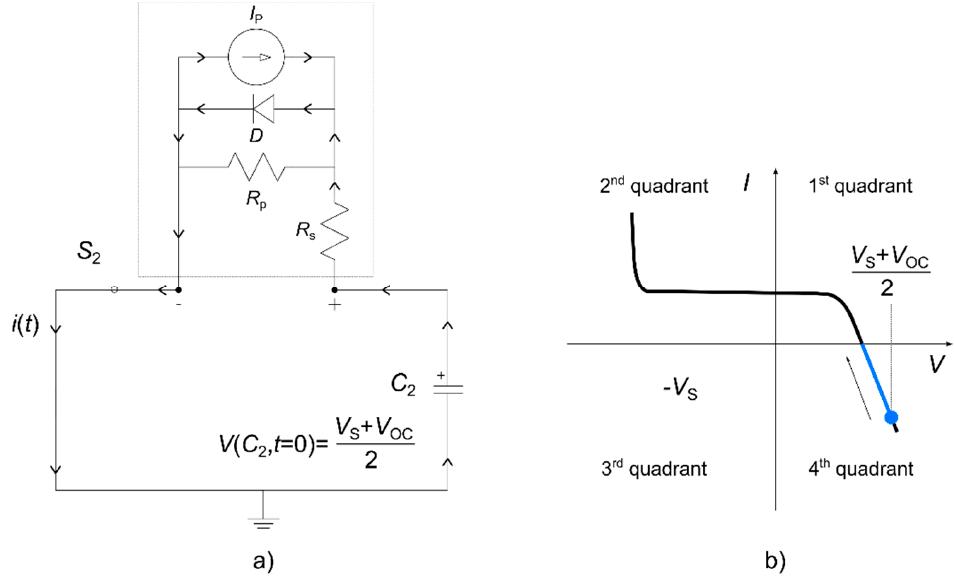
Figure 5. Step 6 of the process of the measurements. ( a ) Equivalent circuit. ( b ) Path on the I-V